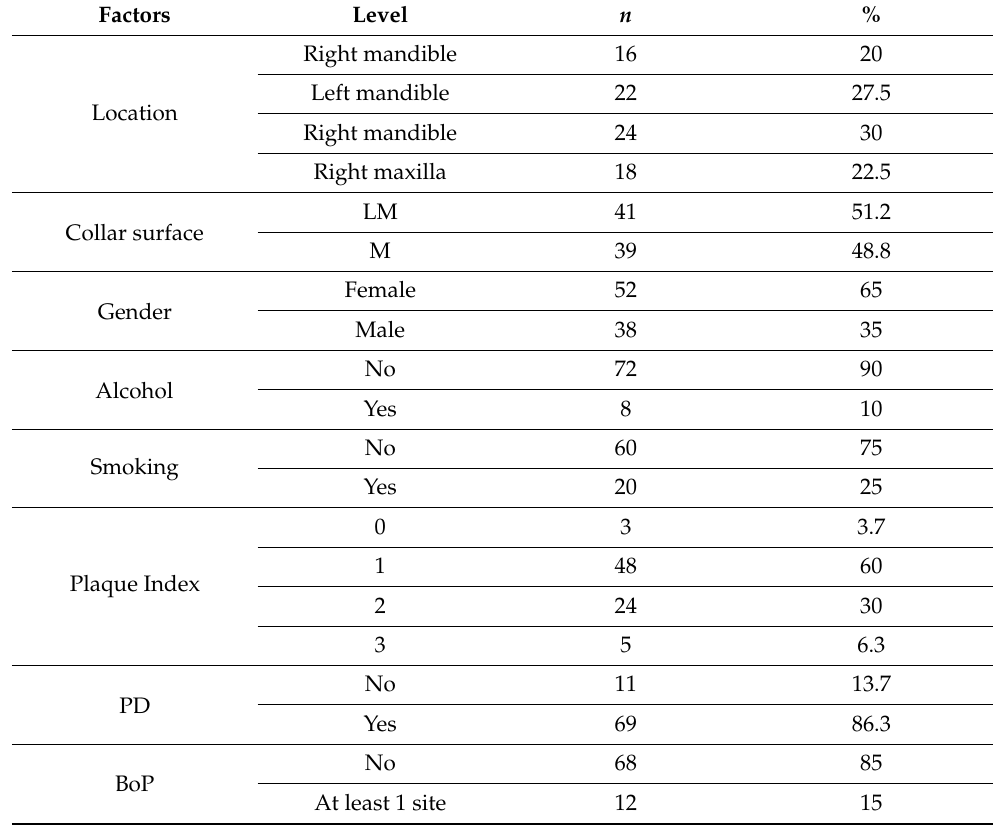
Table 1. Frequencies for each level of the categorical factors.